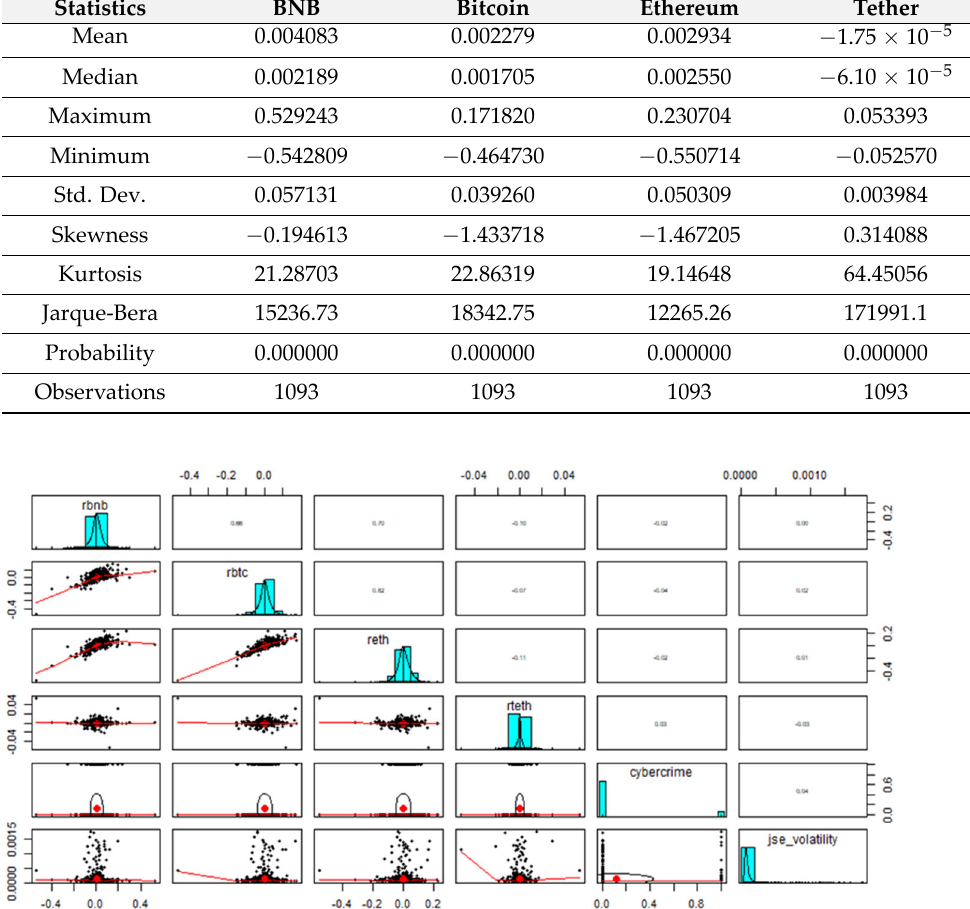
Table 1. Summary statistics of the Cryptocurrencies returns.